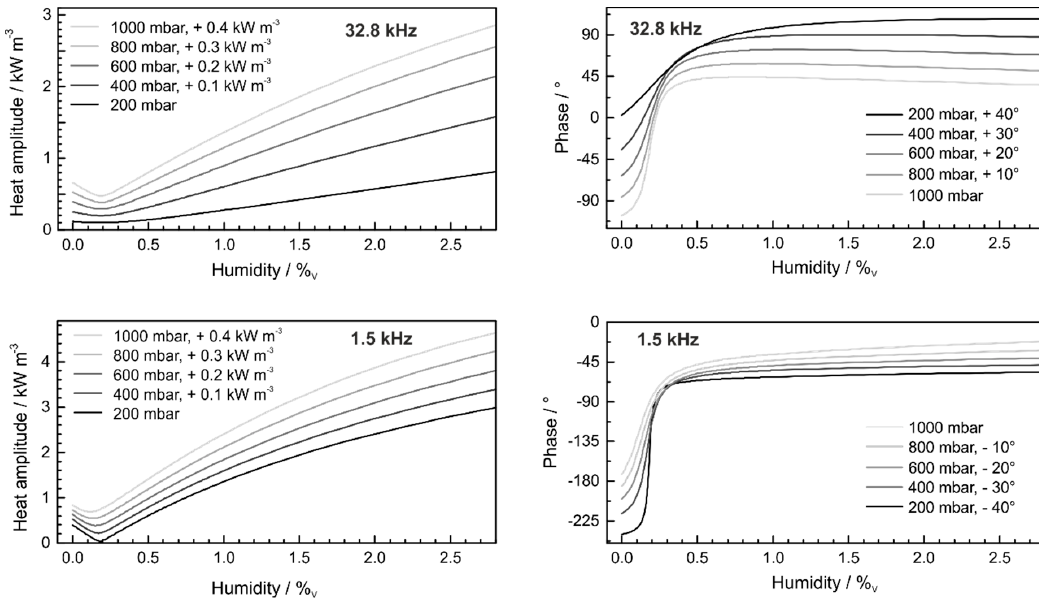
Figure 5. Simulation of the humidity-dependent photothermal response ˆ H of CO in N 2 at wavelength modulated excitation at 32.8 kHz and 1.5 kHz (detection frequency, modulation frequencies were 16.4 kHz and 0.75 kHz, respectively). Simulations were carried out for varying overall pressure. Data were offset as indicated for better visibility.